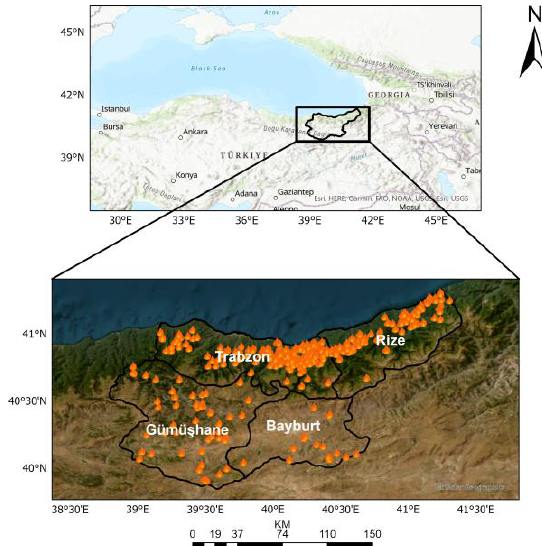
Figure 1 . Location map of the study area, and ground truth fire ignition points.